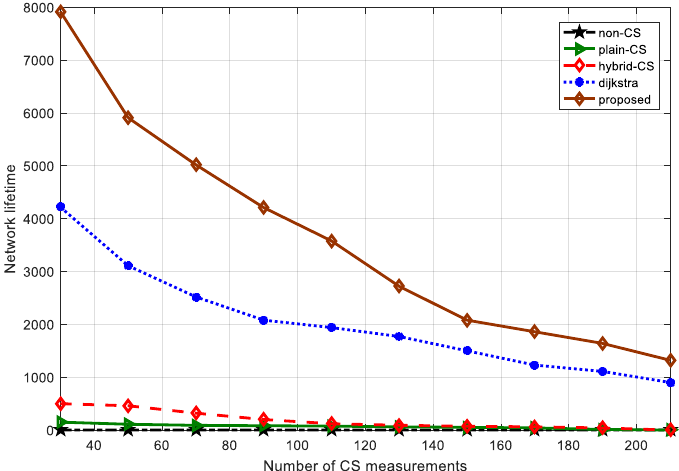
Figure 17. Network lifetime compassion of different data-gathering schemes vs. number of CS measurements.